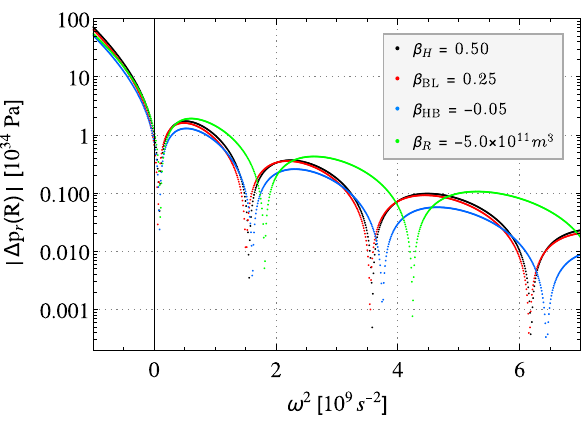
Fig. 2 AbsolutevalueoftheLagrangianperturbationoftheradialpres- sure at the stellar surface on a logarithmic scale for a set of trial values of ω 2 with a central mass density ρ c = 2 . 0 × 10 18 kg / m 3 and different anisotropy ansatze. The minima in each curve correspond to the cor- rectfrequenciesoftheoscillationmodesforequilibriumconfigurations. > 0, the four anisotropic neutron stars are stable against radial Since ω 2 0 oscillations